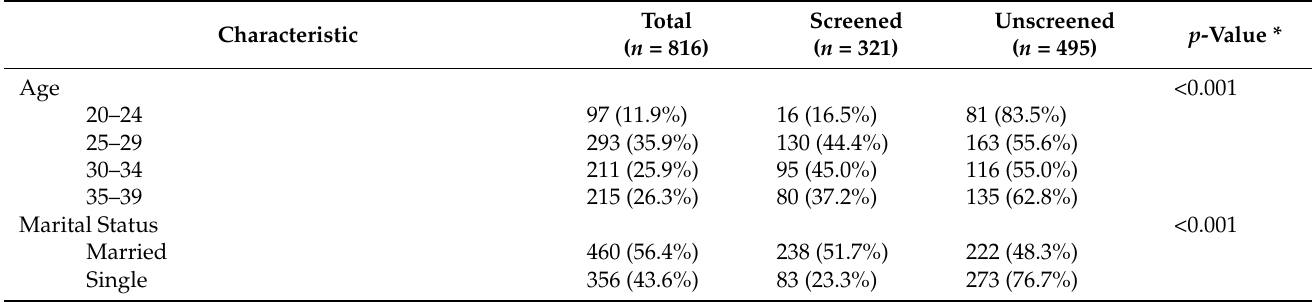
Table 1. Associations between CCS behaviors and personal characteristics (Statistically significant